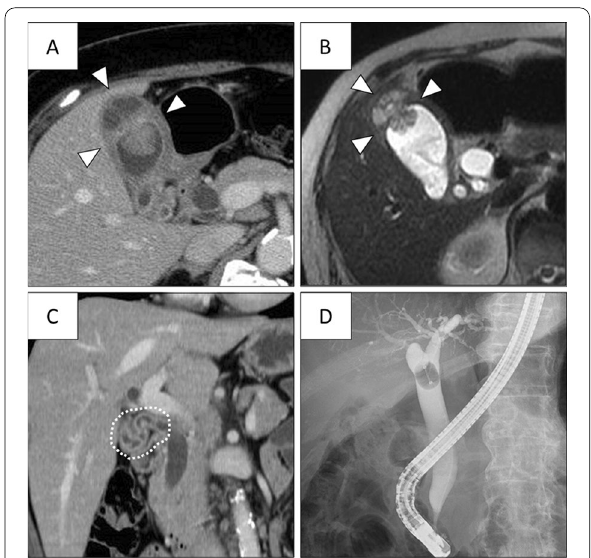
Fig. 1 Enhanced computed tomography and T2-weighted magnetic resonance imaging. A , B A papillary or polypoid tumor was present in the gallbladder. C The gallbladder wall was generally thickened, and the thickening continued to the cystic duct. D Endoscopic retrograde cholangiography revealed a filling defect in the cystic duct